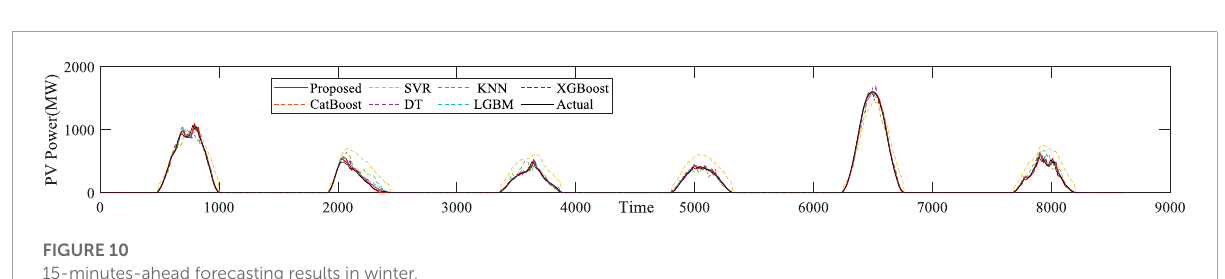
FIGURE 10 15-minutes-ahead forecasting results in